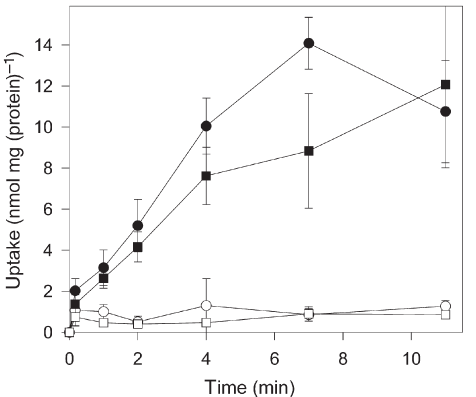
Figure 4. Maltose transport in Pyrococcus furiosus cells. Accumula- tion of 10 mM [ 14 C]-maltose was assayed under anaerobic conditions at 80 °C ( (cid:2) ). Inhibition of maltose accumulation in maltose-grown cells was studied by adding a 100-fold excess of unlabeled maltose ( (cid:3) ), maltotriose ( (cid:4) ) or trehalose ( (cid:5) ). Transport studies were per- formed in